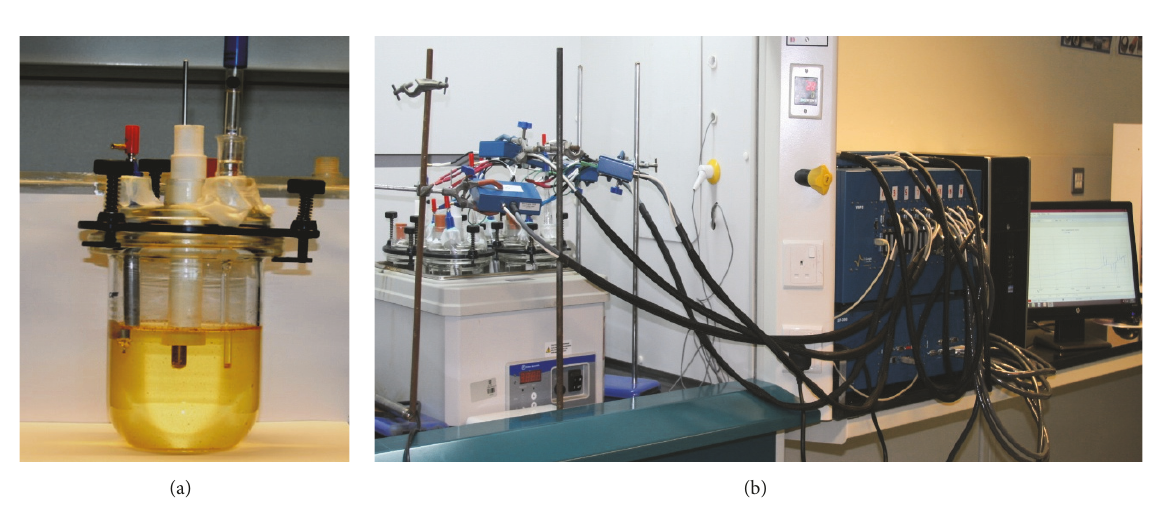
Figure 1: (a) Corrosion cell. (b) Experimental setup for testing under the stagnant